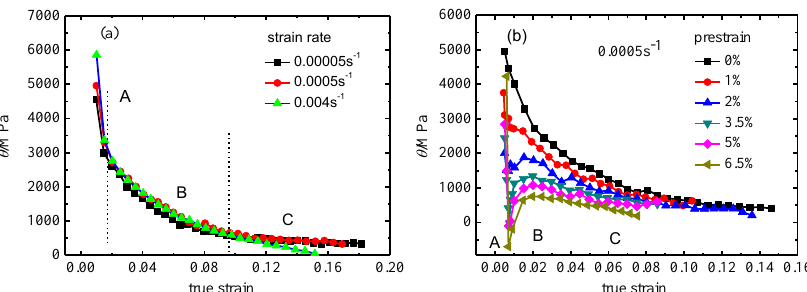
Figure 4. The variation of work hardening rate with true strain. ( a ) As-received CP-Ti at different strain rates and ( b ) prestrained CP-Ti at 0.0005 s −1 .